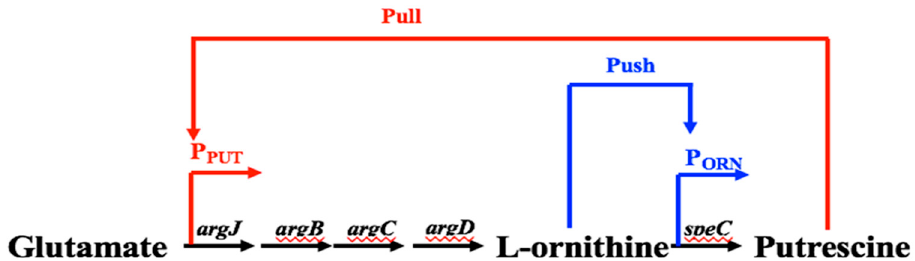
Figure 12. Construction of dynamic genetic circuit in “push” and “pull” mode to promote conversion of L -ornithine to putrescine.